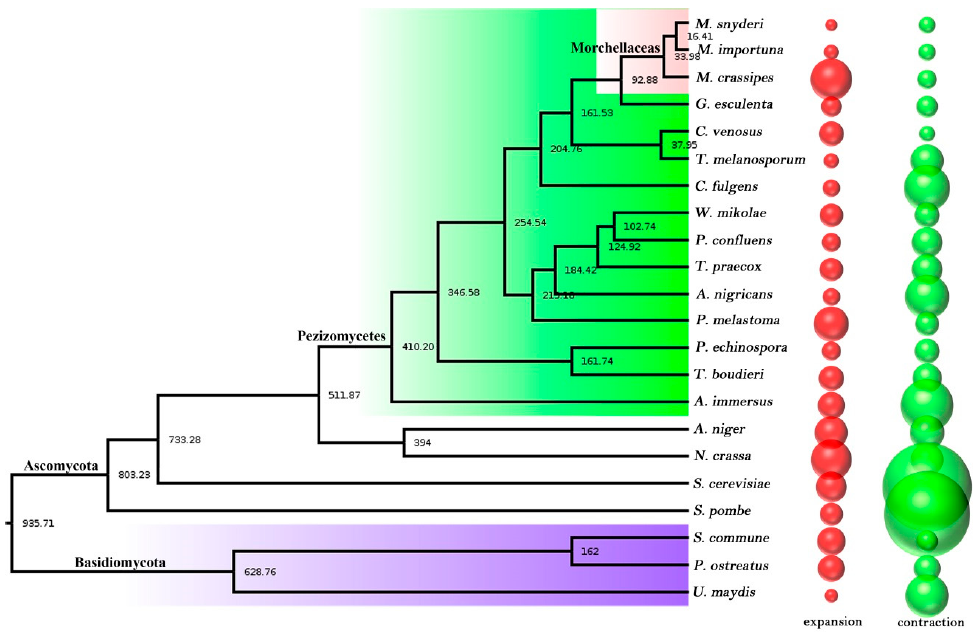
Figure 1. The phylogenetic trees and gene family comparative analysis of 22 species. The number of phylogenetic tree nodes indicated the divergence time, Mya (million years); the bubble diagram on the right represented the expansion (red) and contraction (green) of the gene family among species; and the diameter of the bubble represented the number of genes that expanded and contracted.